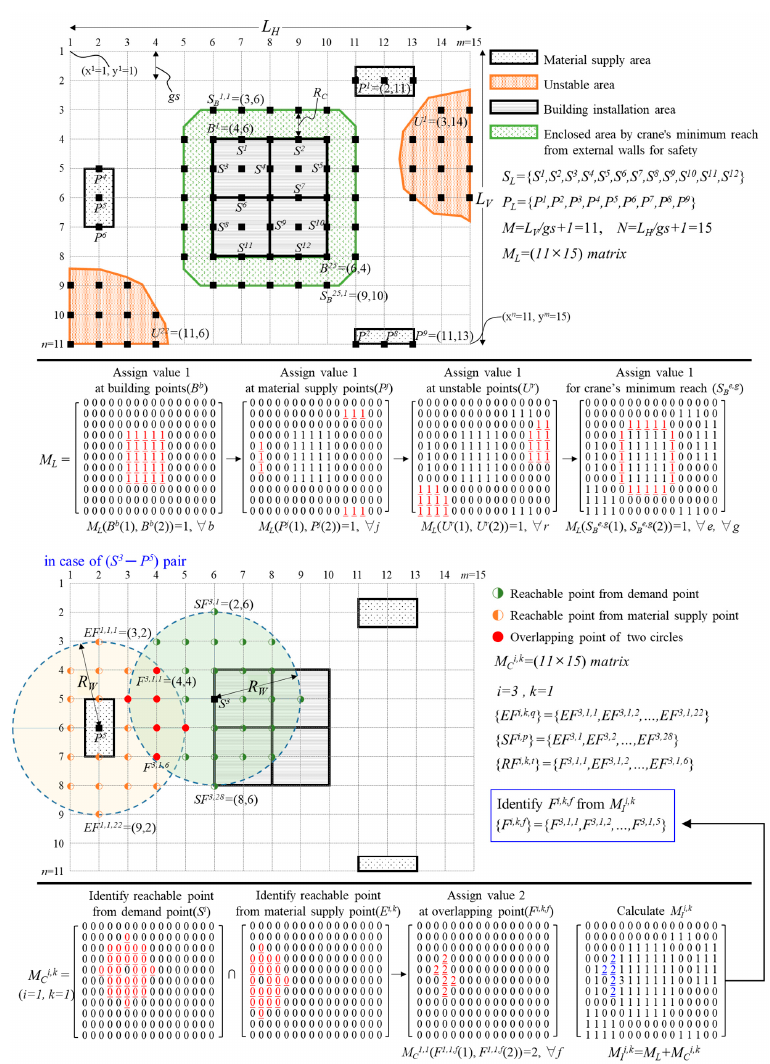
Figure 1. Procedure of identifying the feasible locations of the mobile crane.